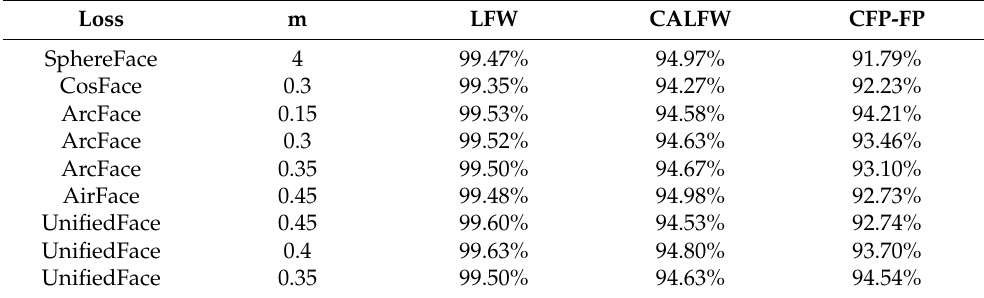
Performance comparison between UnifiedFace and popular loss functions in lightweight